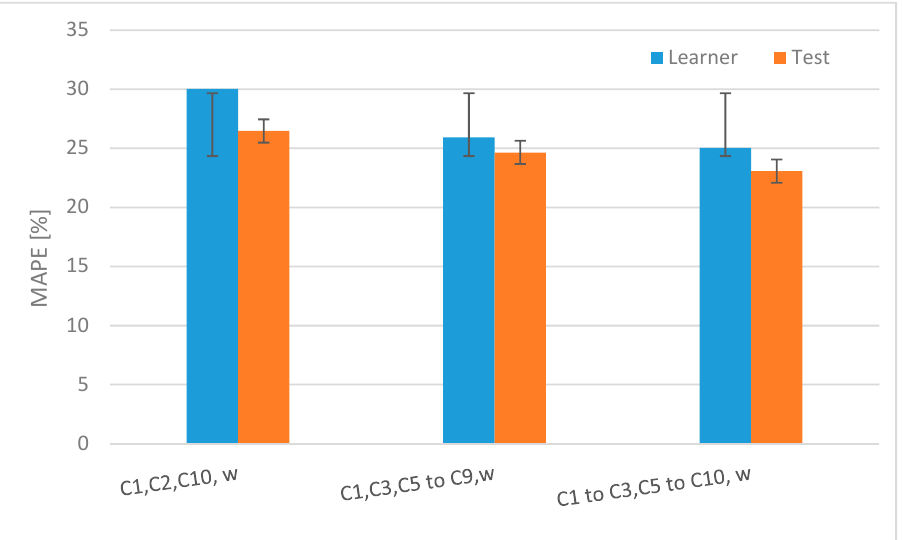
Figure 7. Assessment of the quality of the developed models of the total waste accumulation indicator based on studied set of input variables (C1 to C10).